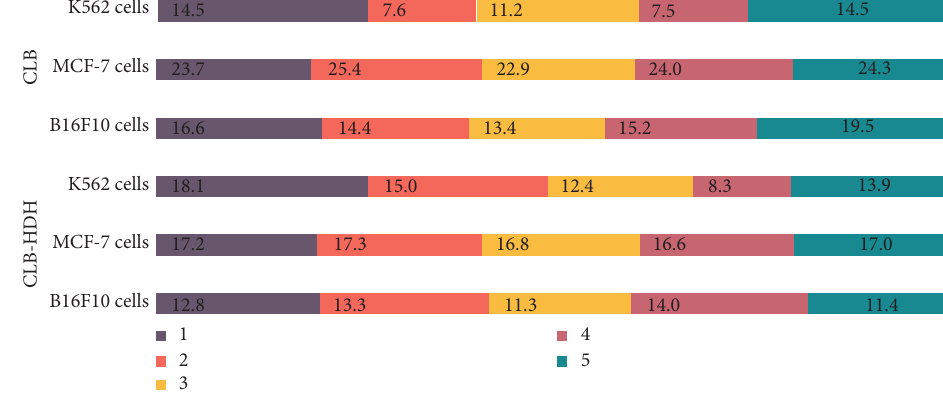
Figure 4: Cytotoxicity test